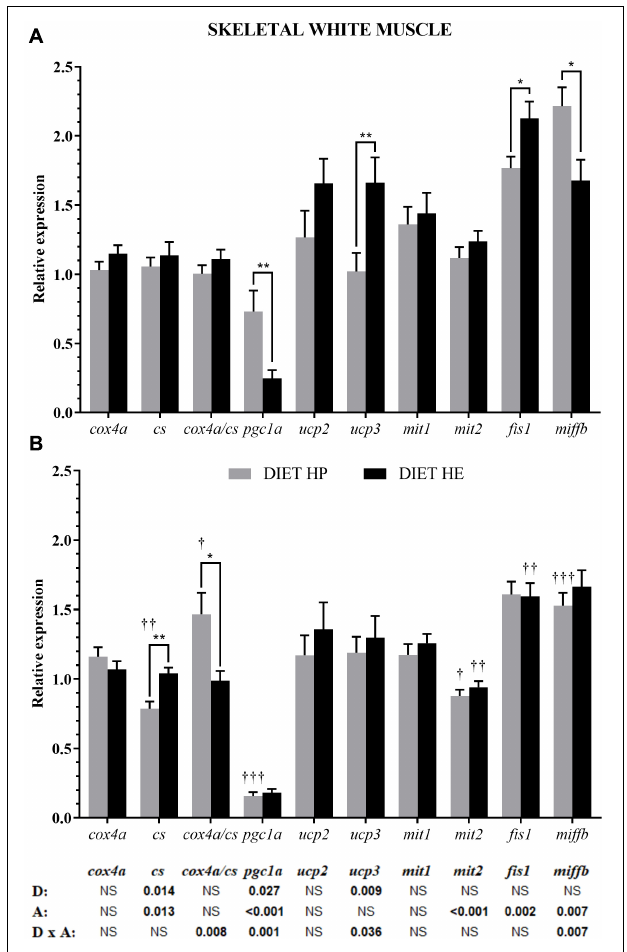
FIGURE 1 | Relative gene expression of the enzymes in energy metabolism, markers of mitochondrial biogenesis and markers of mitochondrial dynamics in the liver of gilthead seabream fed the HP or HE diet under conditions of voluntary swimming (A) or sustained swimming (B) . Data are shown as the mean ± SEM ( n = 12 for VS and n = 16 for SS conditions). The factorial statistical analysis was assessed by two-way ANOVA and the p -values of the diet (D), swimming activity (A) and the interaction (D × A) are displayed at the bottom of the figure. Pairwise comparisons were assessed by unpaired Student’s t -test. * p < 0.05 and ** p < 0.01 between diet groups (HP AND HE); † p < 0.05 and †† p < 0.01 between swimming activity groups (VS and SS).